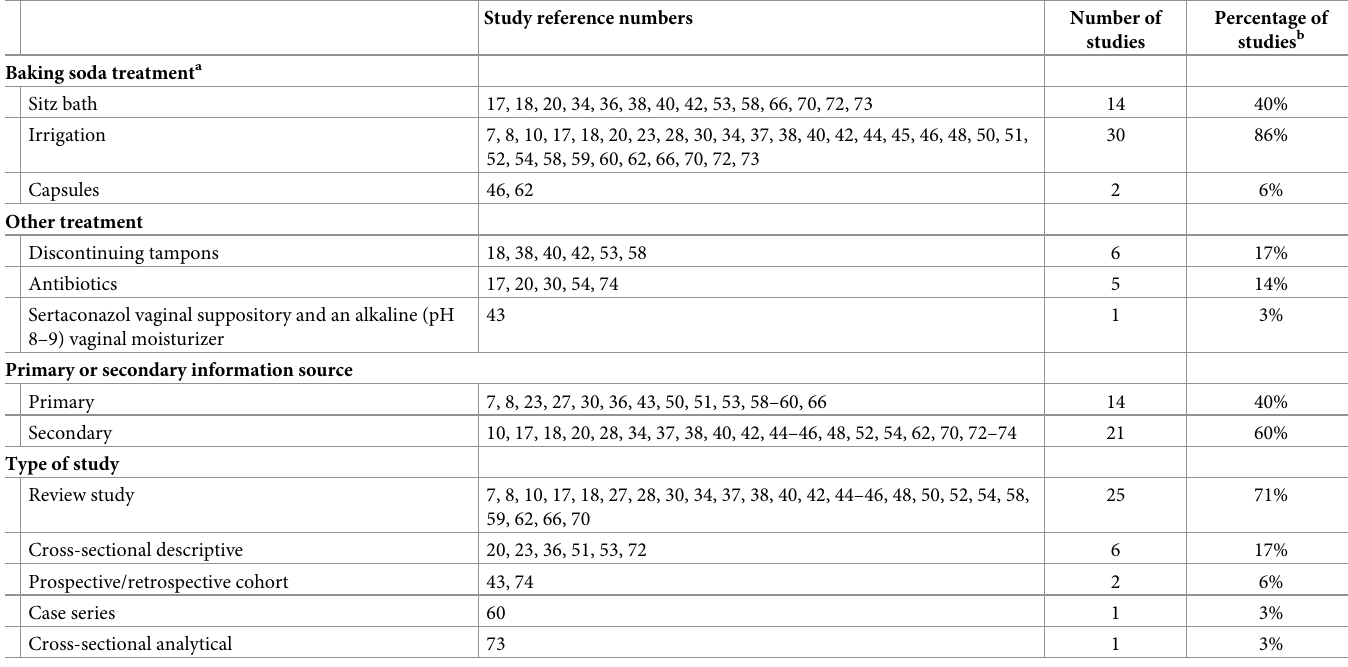
Table 5. Summary of treatment recommendations (n = 35